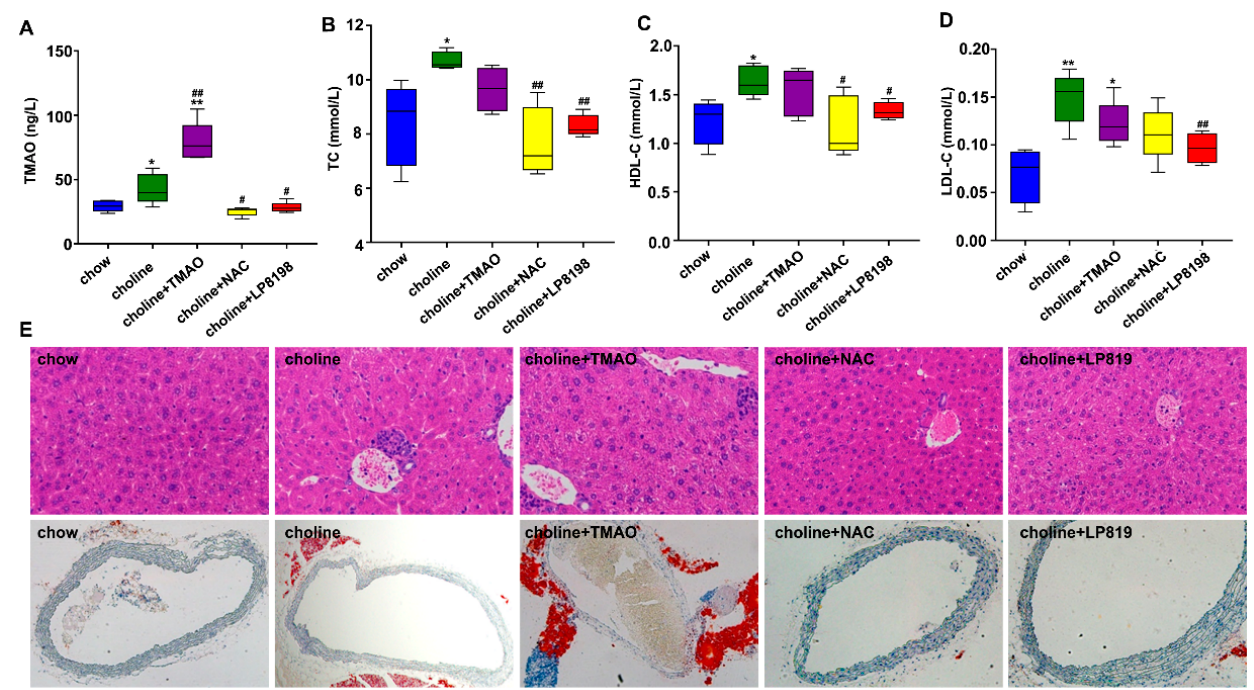
Figure 5. Choline diet and TMAO aggravates the occurrence of atherosclerosis in C57BL/6 mice. ( A ) TMAO levels were detected at indicated time points by ELISA kits. ( B ) Serum total cholesterol (TC). ( C ) Serum high-density lipoprotein cholesterol (HDL-C). ( D ) Serum low-density lipoprotein cholesterol (LDL-C). ( A – D ). Values are the mean ± SD; n = 5 per group, two-way ANOVA followed by a Tukey post hoc test. * p < 0.05; ** p < 0.01 vs. the chow group; # p < 0.05; ## p < 0.01 vs. the choline group. ( E ) Representative images of H&E staining at liver and oil-Red O staining at aortic root in C57BL/6 mice fed with choline diet with or without TMAO, NAC, LP8198 for 12